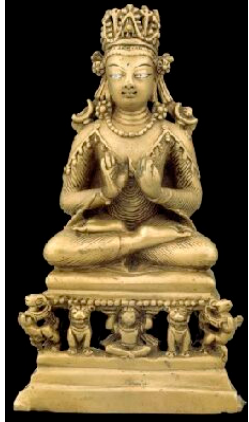
Figure 36. Vairocana Buddha performing the dharmacakra-pravartana mudr ā . Commissioned by Var ṣ a, 645 or 654 C.E. Kashmir or Gilgit. Brass. 29 cm H. Anna Maria Rossi and Fabio Rossi Collection (88515). https://www.himalayanart.org/items/88515. Copyright@ 2018 Himalayan Art Resources Inc.